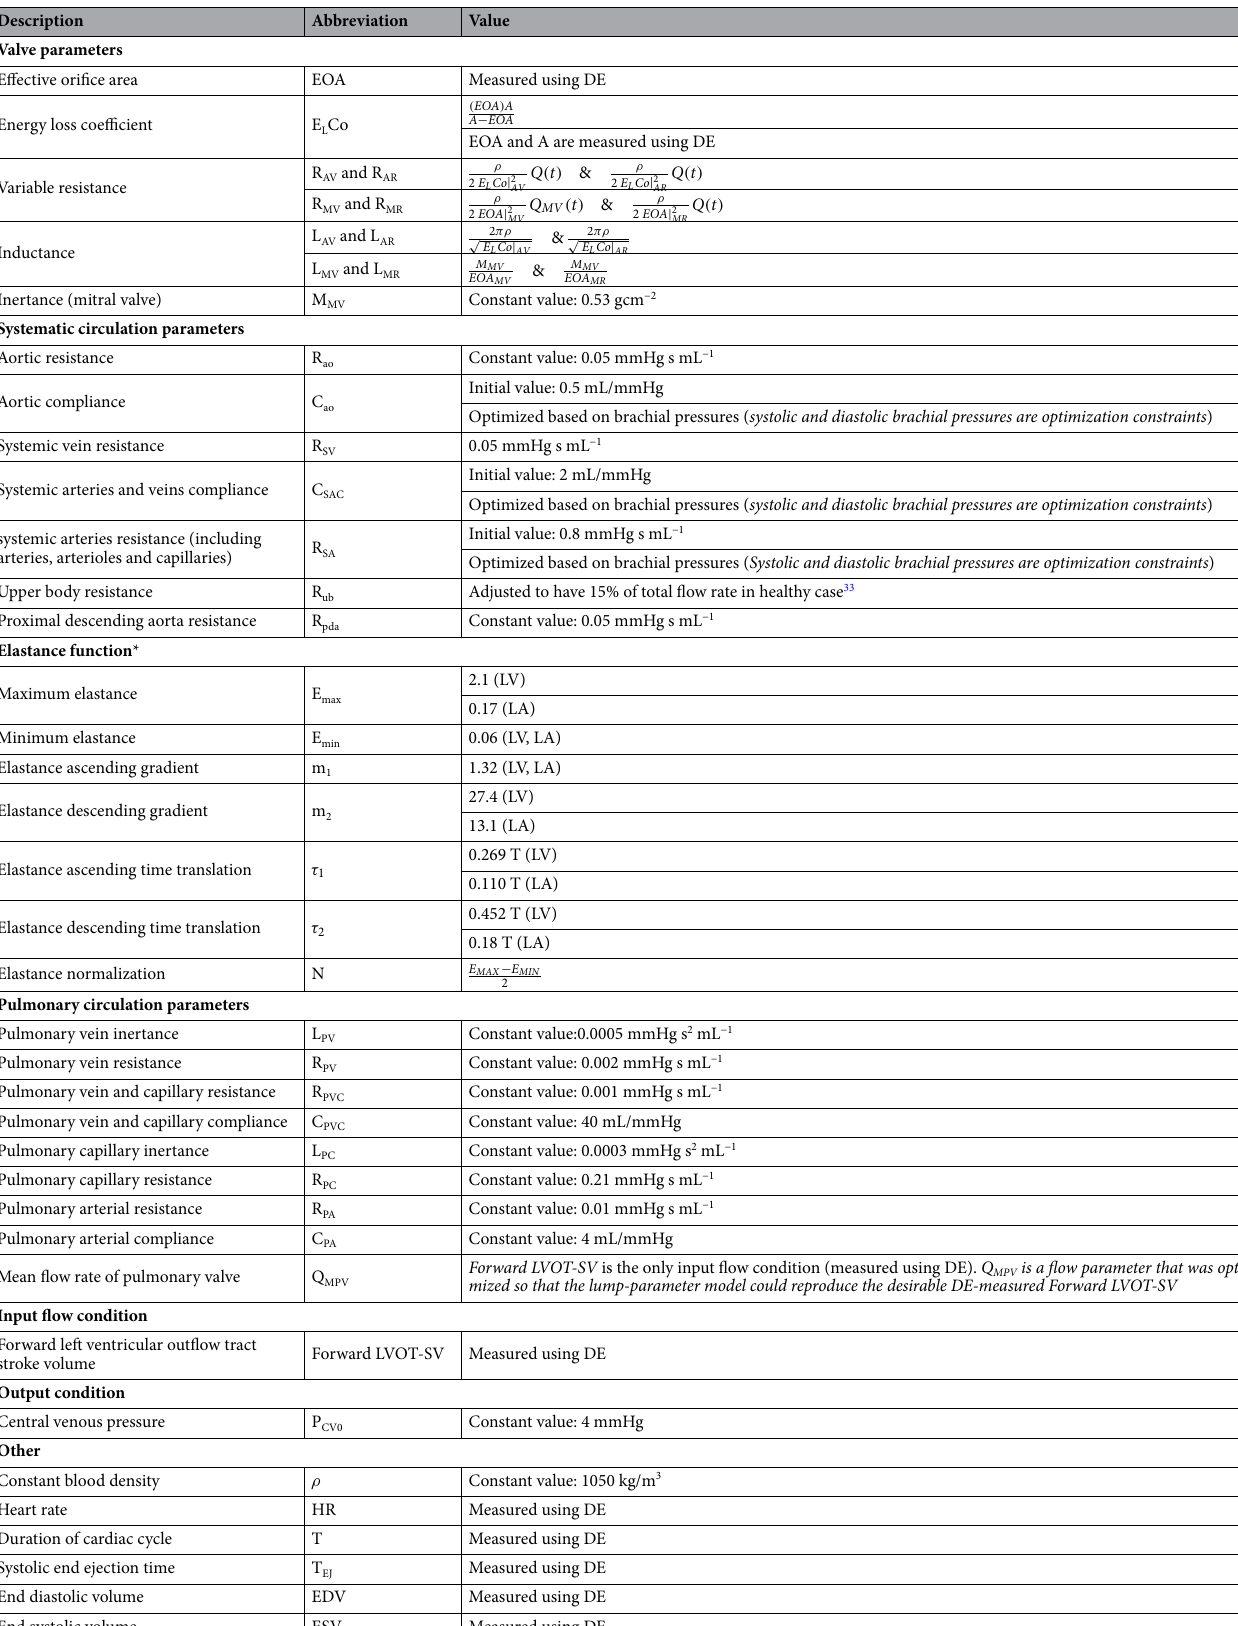
Table 1. Cardiovascular parameters. Summarized parameters used in the lumped-parameter modeling to simulate all patient-specific